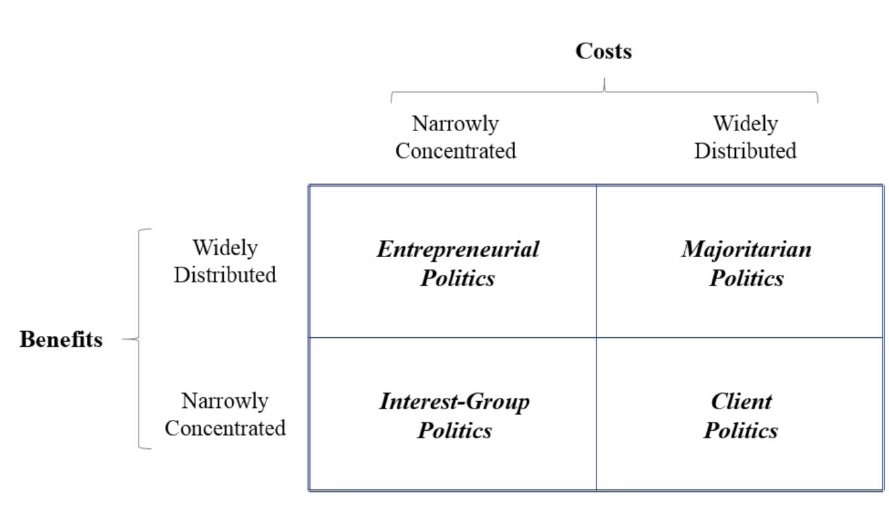
Figure 1. Cost–benefit distribution and four di ff erent types of policy